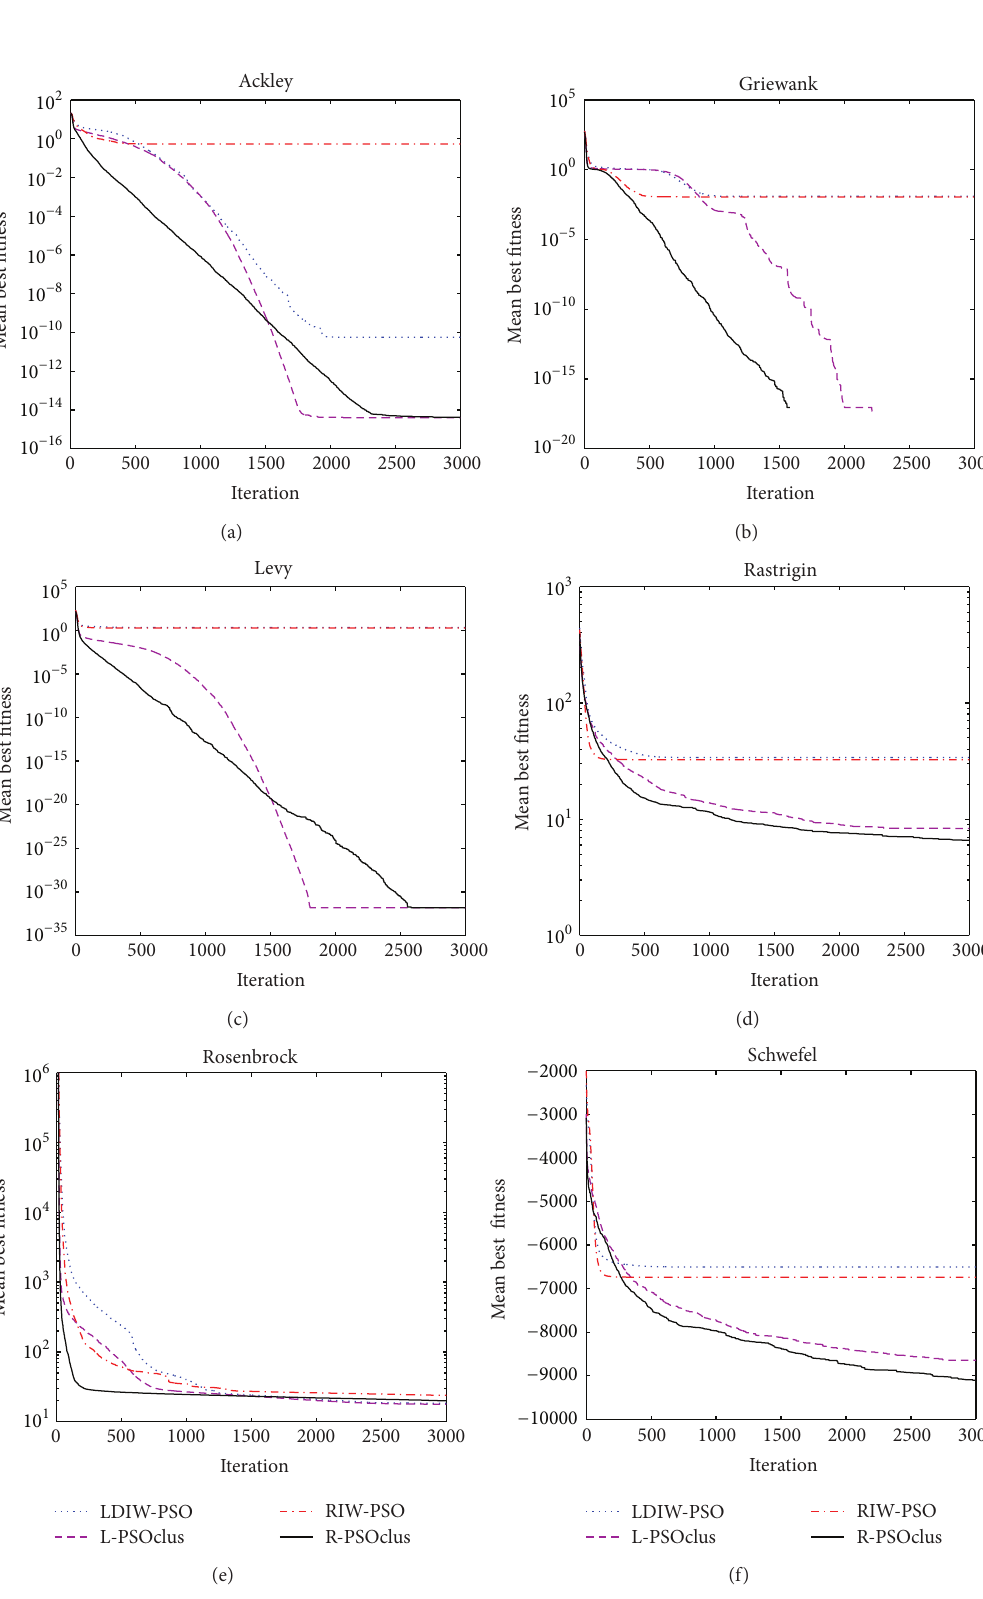
Figure 2: Convergence graphs for 6 of the scaled benchmark problems with dimension of